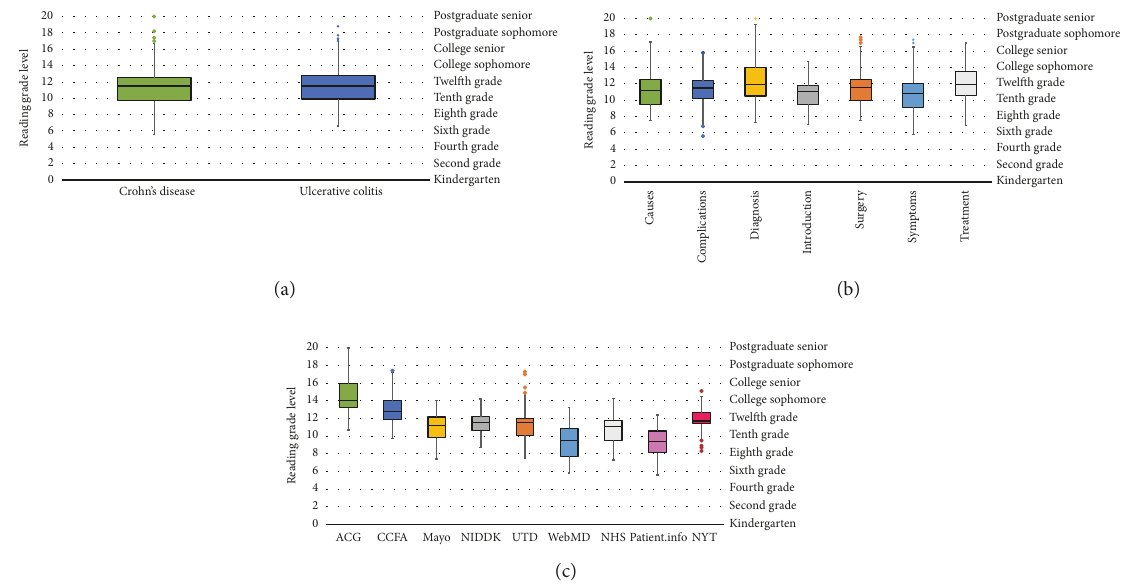
Figure 2: (a) Box and whisker plots depicting distribution of readability grade levels for Crohn’s disease and ulcerative colitis. Median reading grade level for both diseases is 11.5. (b, c) Box and whisker plots of readability grade levels by subsection and source website, respectively. ACG: American College of Gastroenterology; CCFA: Crohn’s and Colitis Foundation of America; Mayo: Mayo Clinic; NIDDK: National Institute of Diabetes and Digestive and Kidney Diseases; UTD: UpToDate, Beyond the Basics; NHS: National Health Service; NYT: New York Times Health Guide.